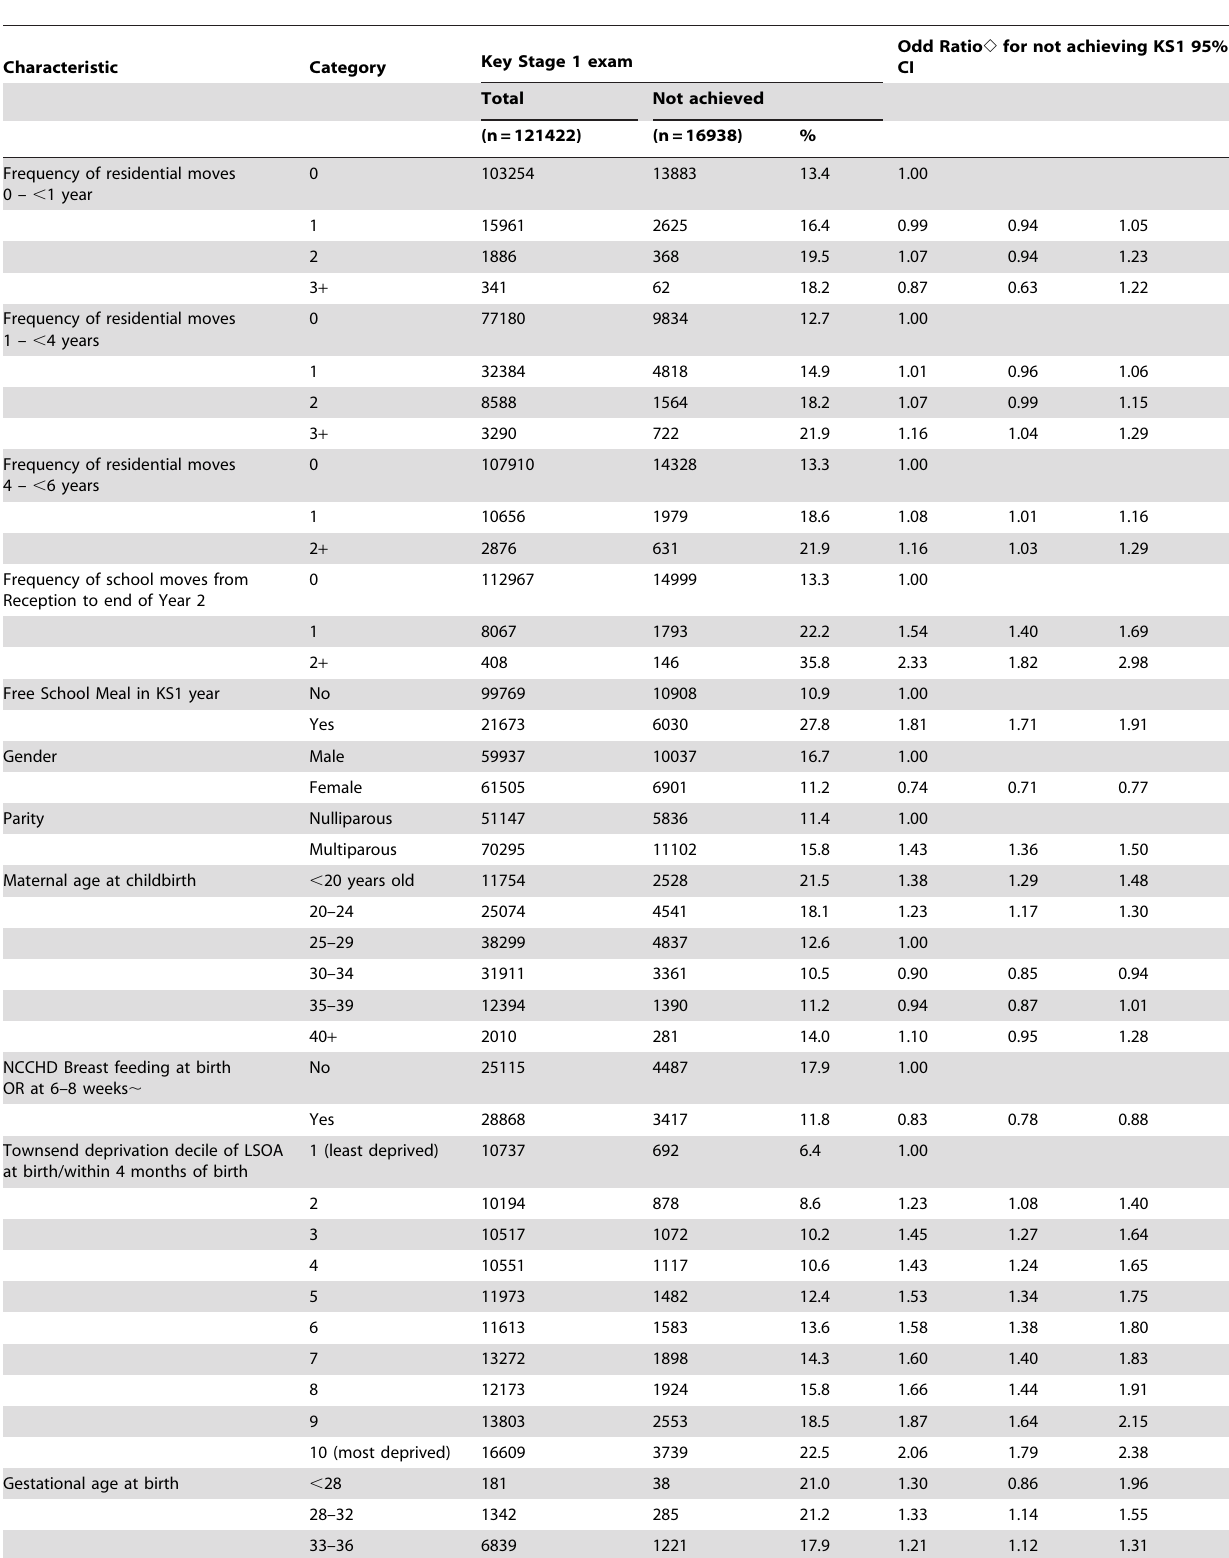
Table 2. Association between residential moves and educational outcomes adjusted for all variables shown in the table (Odds ratios and 95%